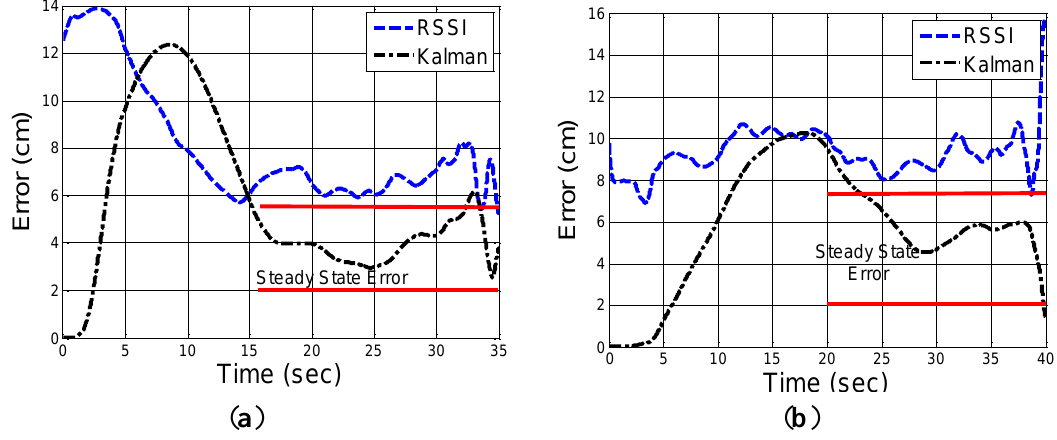
Figure 9. The location estimation error of the RSSI vs. the Kalman filter, for the circular ( a ) and zigzag patterns ( b ). The Kalman filter converges to the steady state error after approximately 15, and 20 s.